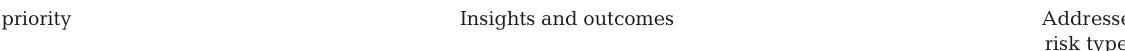
Table 2. Research and development priorities to understand, quantify and mitigate different types of environmental risk associated with biofouling management in salmon aquaculture: health or disease risks (HDR); deposition or pollution risks (DPR); invasive species risks (IR) and exacerbated biofouling risk